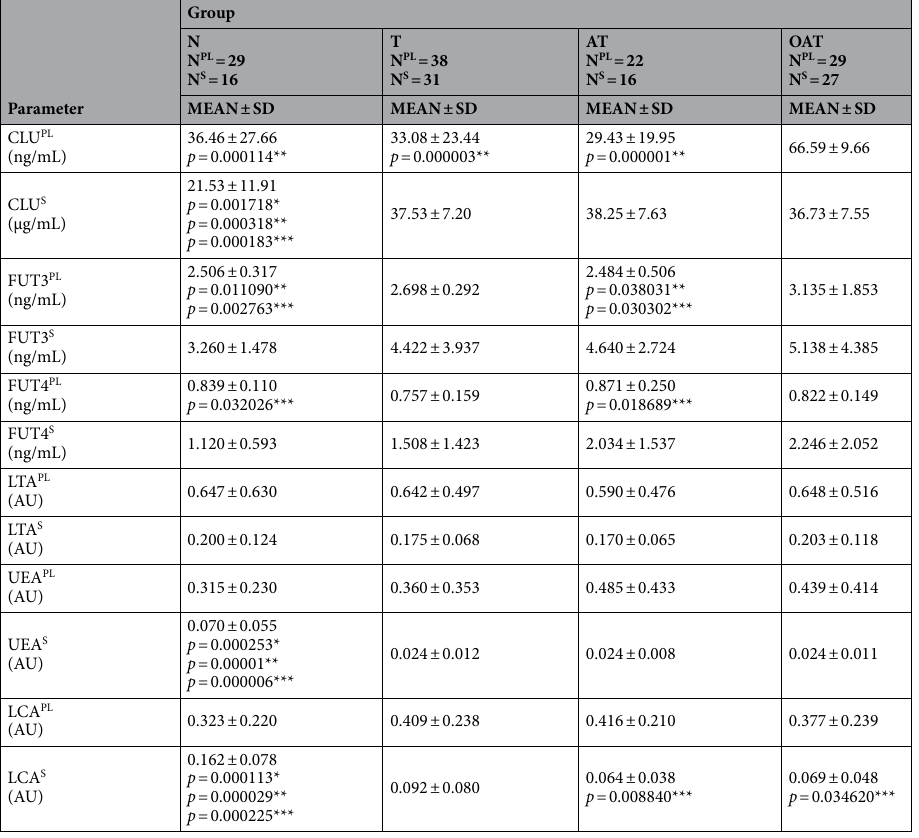
Table 1. The values of selected parameters measurements in seminal plasma and serum groups of patients with fertility problems. CLU PL —seminal plasma CLU concentration; CLU S —serum CLU concentration; FUT3 PL —seminal plasma FUT3 concentration; FUT3 S —serum FUT3 concentration; FUT4 PL —seminal plasma FUT4 concentration; FUT4 S —serum FUT4 concentration; LTA PL —relative reactivity of seminal